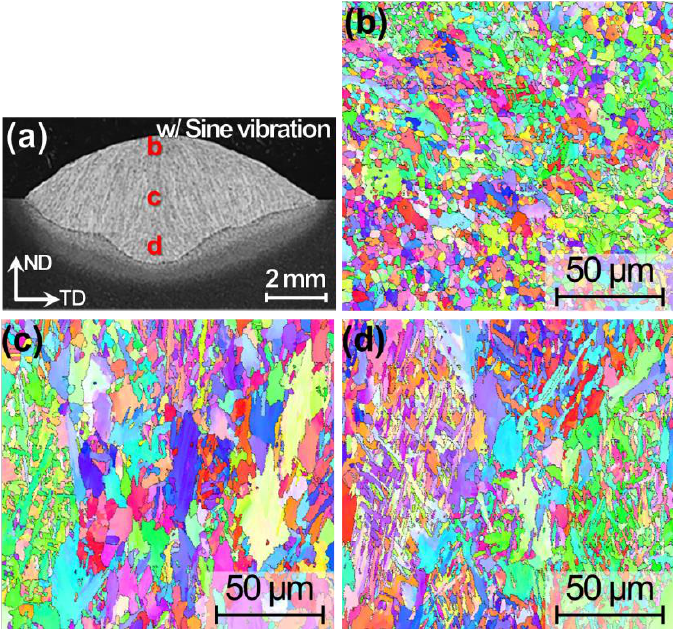
Figure 3. Cross-sectional ( a ) OM image and ( b–d ) electron back-scatter diffraction-inverse pole figure (EBSD-IPF) maps for TP-GMAW specimens at 1.2 m/min w/ sine vibration (F = 250 Hz, G = 1.2 m/s 2 and T = 30 s).